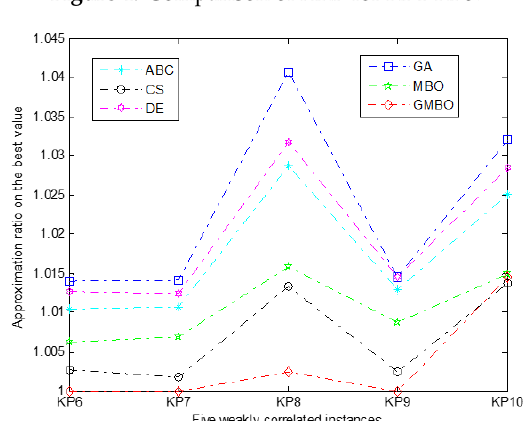
Figure 5. Comparison of ARB for KP6-KP10.